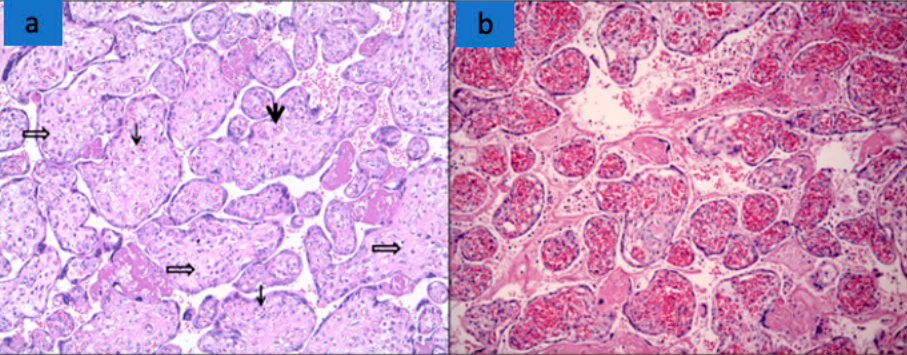
Figure 1. Signs of MVM in placenta from woman with SARS-CoV-2 infection: spiral artery atherosis with lipid laden macrophages (hematoxylin-and-eosin stain; original magnification 25×).